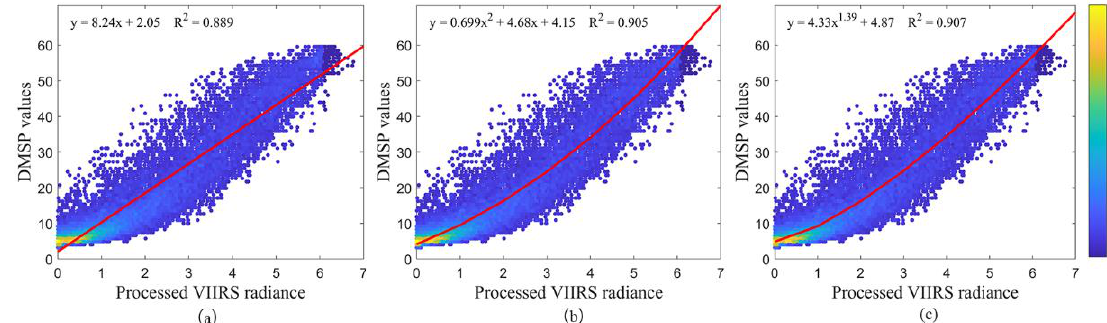
Figure 4. Correlation between the Defense Meteorological Satellite Program (DMSP) and processed Visible Infrared Imaging Radiometer Suite (VIIRS) values at the pixel scale for the ( a ) linear model, ( b ) quadratic polynomial model and ( c ) power function model.